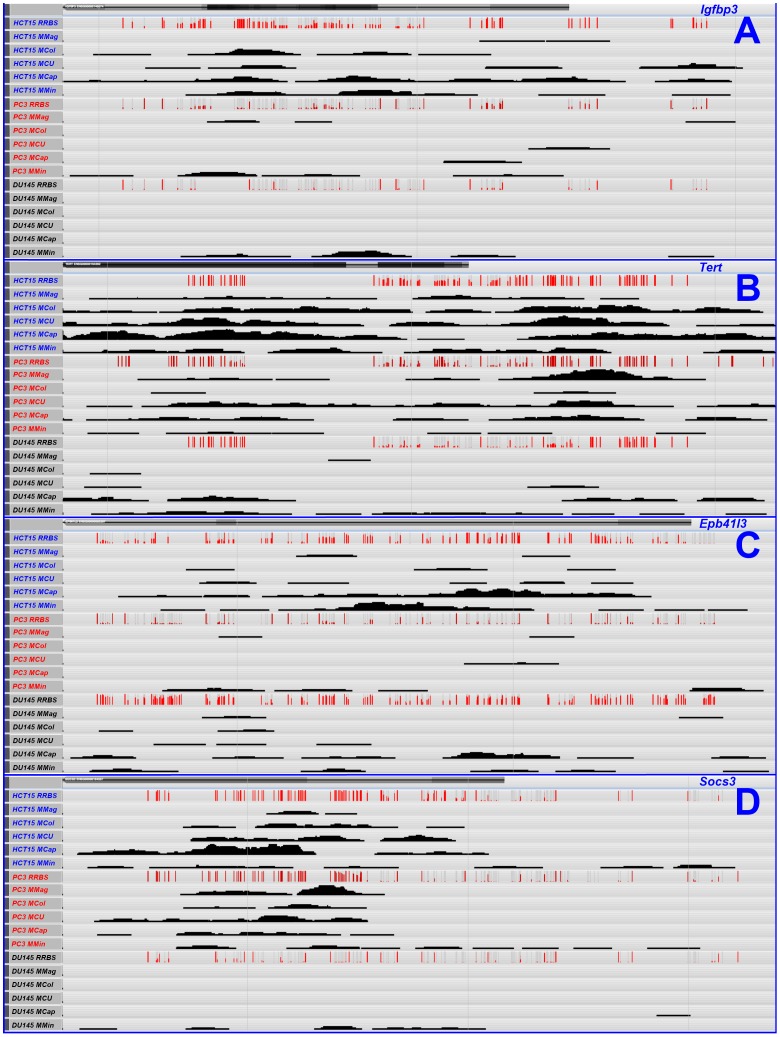
Exploratory comparison of MBD-seq and RRBS data.Visual comparison of MBD-seq results for MethylMagnet (MMag), MethylCollector (MCol), MethylCollector Ultra (MCU), MethylCap (MCap) and MethylMiner (MMin) with RRBS data for the promoter regions of four selected loci, i.e. Igfbp3 (panel A, chromosome 7, depicted from position 45959883 to 45962146), Tert (panel B, chromosome 5, 1293850 to 1296219), Epb41l3 (panel C, chromosome 8, 5628365 to 5630973) and Socs3 (panel D, chromosome 17, 76354158 to 76357420). CpGs assessed by RRBS are indicated as vertical red (fraction methylated)/grey (fraction unmethylated) bars. Note that RRBS only assesses the methylation status of a (sometimes variable) subfraction of CpGs.